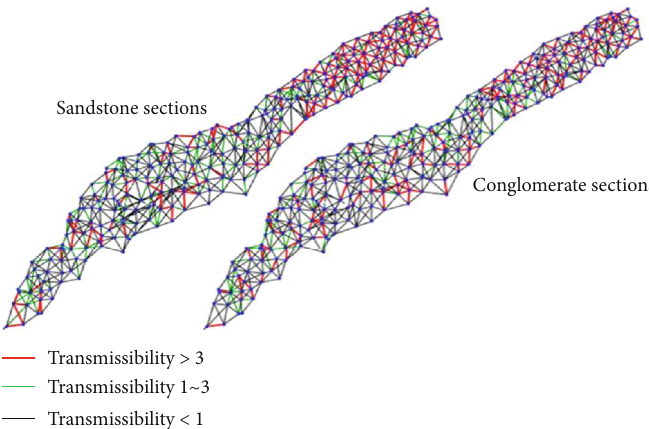
Conglomerate sections